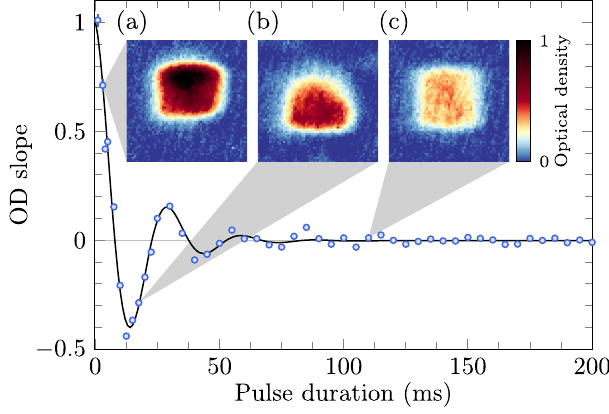
FIG. 3. Relaxation to a uniform density. The gas is prepared in a spin-polarized j ↓ i state without the rf field. The magnetic field is set according to Eq. (3), overcompensating gravity for this state by 5.9%. At t ¼ 0 , the rf field with Ω = 2 π ≈ 15 . 7 kHz is switched on and flattens the time-average potential. The in situ density of gas is recorded from the side of the cylindrical trap after variable rf pulse duration (insets showing 3, 17.5, and 110 ms). The color bar represents the optical depth (OD) in the absorption image. The main figure shows the density relaxation dynamics, quanti- fied by the average change in the OD from side to side of the image. The error bars represent 1 σ deviation from linear fit to the OD slope. We fit the data with g ð t Þ ¼ ae − t= τ cos ð 2 π ft þ ϕ Þ þ b (solid line) and obtain τ ¼ 16 ð 1 Þ ms and f ¼ 33 . 6 ð 7 Þ Hz. The reduction of the OD for longer pulse duration is due to decoherence to a spin-balanced mixture while measuring atoms only in the j ↓ i state (see the main text). This measurement is done at a magnetic field of approximately 203 G, where the scattering length between states j ↓ i and j ↑ i is a ≈ − 1152 a 0 ( a 0 is the Bohr